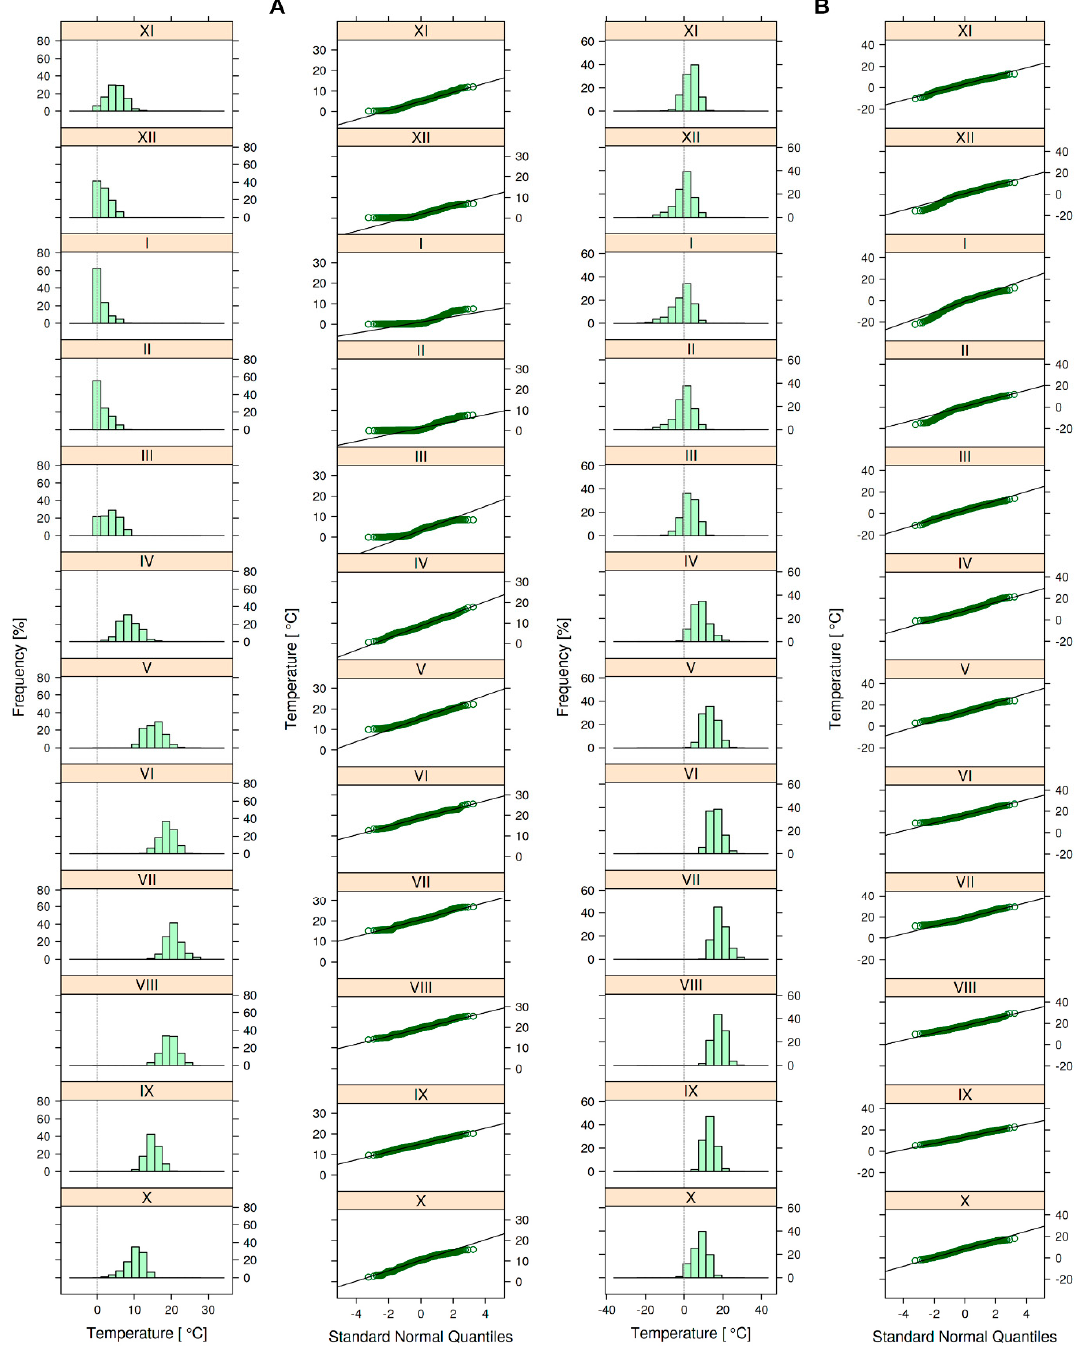
Figure 5. Frequency histograms and quantile plots of the distribution of monthly water temperature series for the Note ć in Pako ść ( A ), and air temperature in Pi ł a ( B ) (1987–2013).